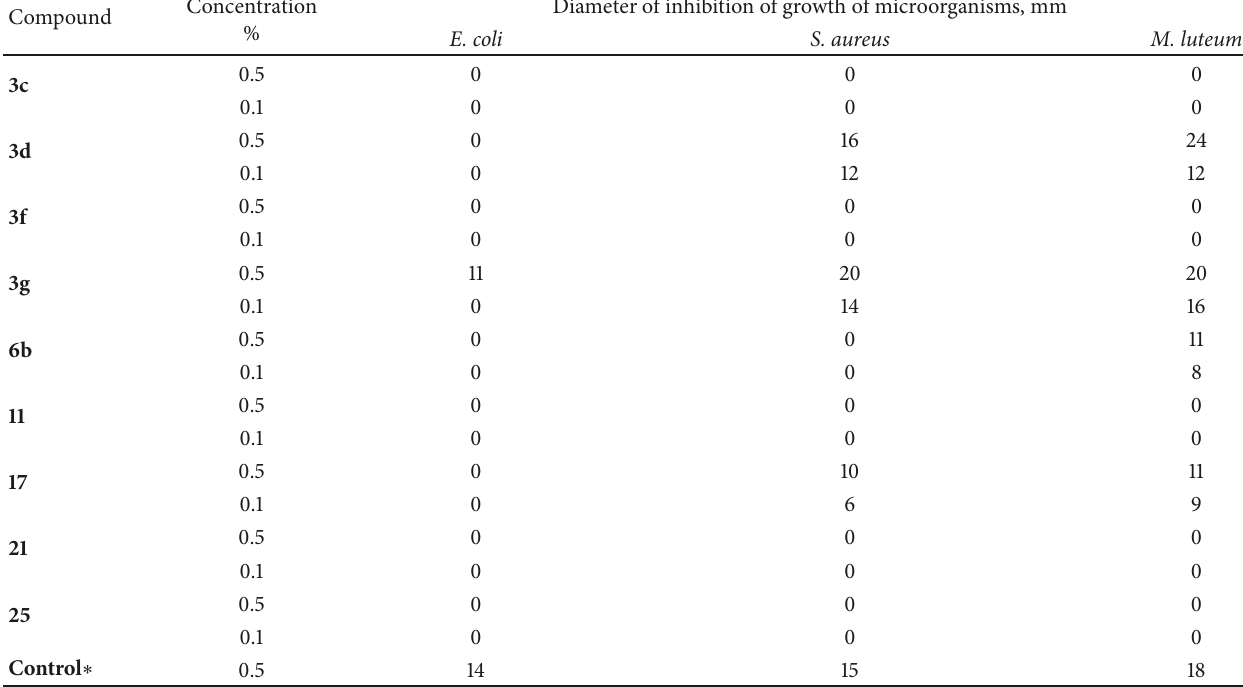
Table 1: Antibacterial activity of the compounds determined by diffusion method.